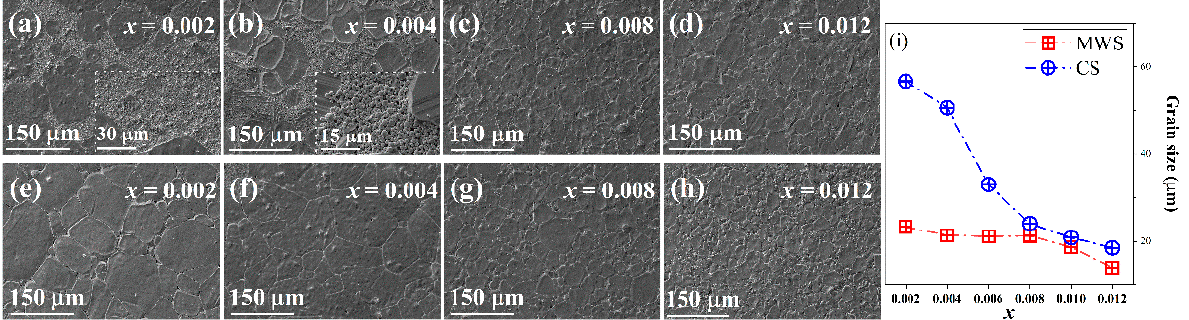
Figure 4. Surface morphology images of the BTS-BCT- x BF ceramics sintered by ( a - d ) MWS and ( e - h ) CS, ( i ) Grain sizes of MWS and CS BTS-BCT- x BF ceramics. Table 1. Density of BTS-BCT- x BF ceramics sintering by MWS and CS. x Sintering Method Density (g/cm 3 ) Sintering Method Density (g/cm 3 ) 0.002